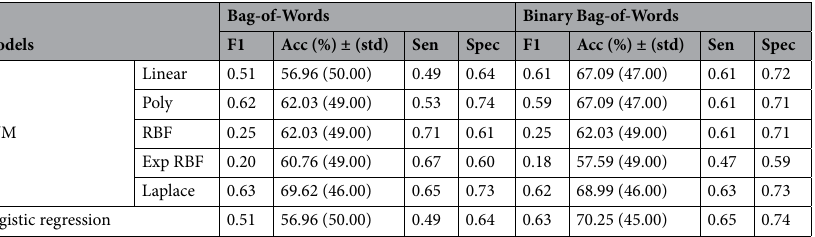
Table 5. Performance result obtained with logistic regression and SVM applied to Bag-of-Words and Binary Bag-of-Words feature representation of the data.